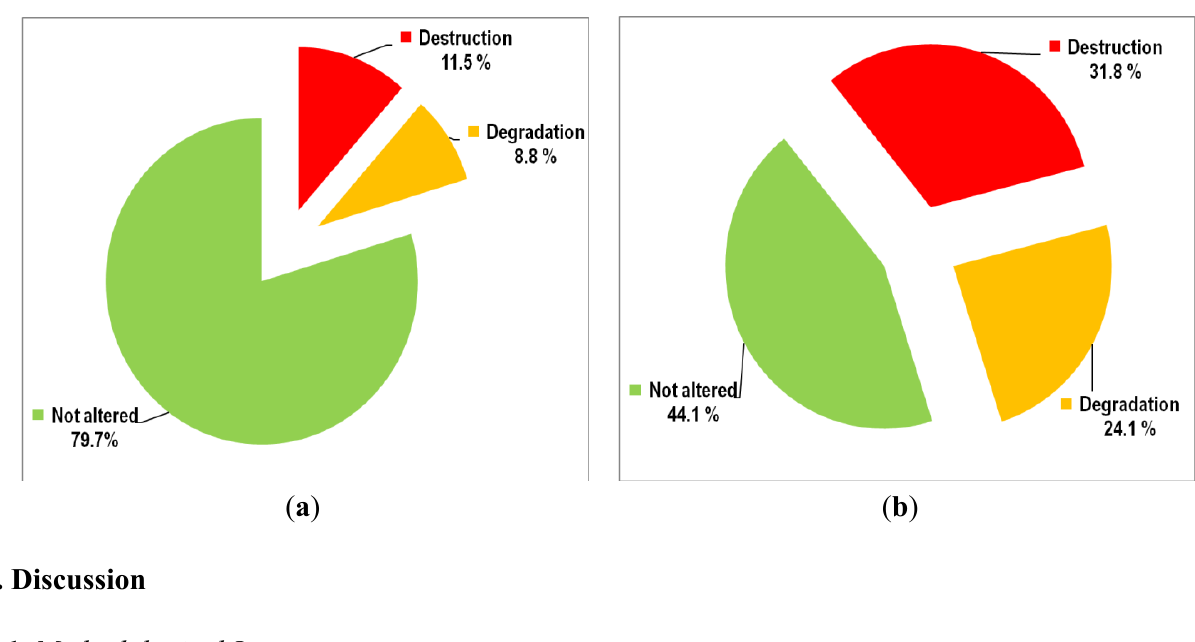
Figure 7. Rates of destruction and degradation of dry heaths in the SCI Os Ancares–O